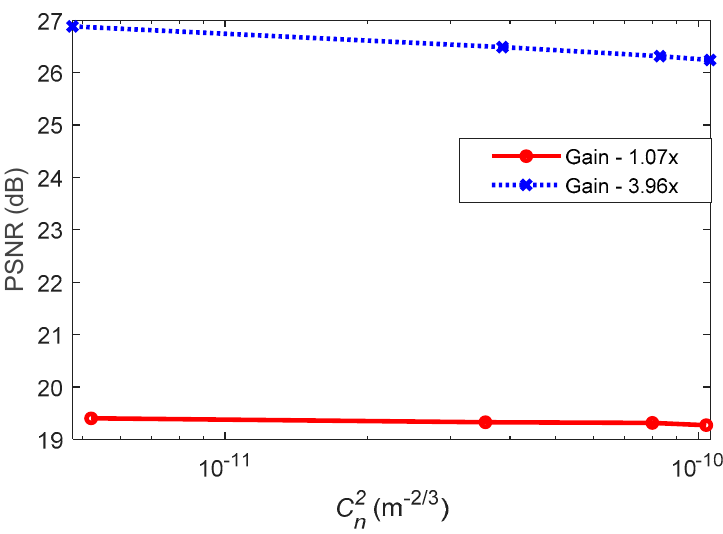
Figure 5. The peak SNR (PSNR) as a function of C 2 n for the two gain factors. Note that the corresponding σ 2 for the experimentally measured C 2 for different AT n R strengths were determined using Equation (3) for L s equal to the length of the AT chamber (7.2 m), which are given in Table 3. Note that both the image contrast and its brightness increase with the camera’s gain factor, since the signal is amplified prior to the digitizing process [46]. The choice of the two gain factors (i.e., low and high) is used to illustrate the image contrast/brightness effects under